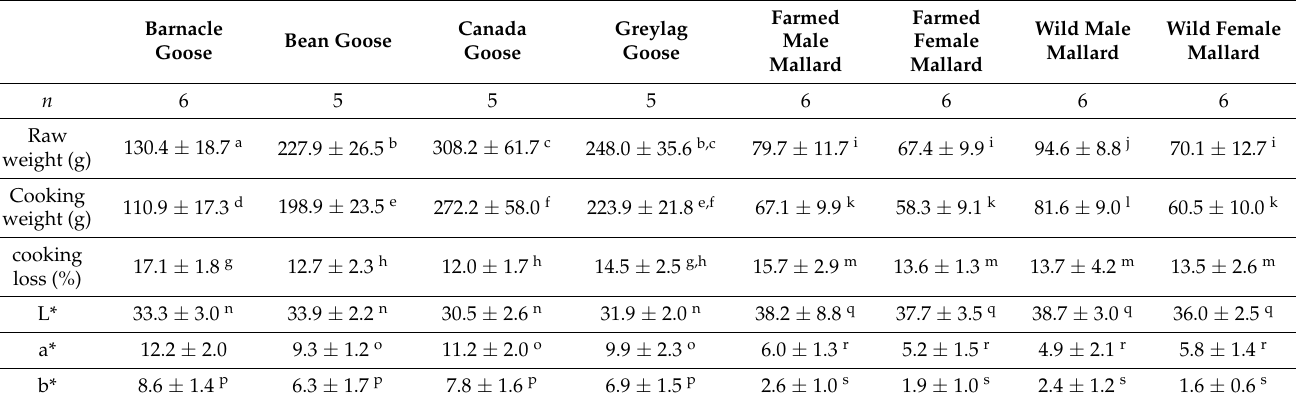
Table 5. Physical characteristics of meat from goose and mallard. Mean values ( ± sd) for raw weight (g), cooked weight (g), and cooking loss (%), together with the number of individual breast muscle samples ( n ) in all groups. Mean values ( ± sd) for lightness (L*), redness (a*), and yellowness (b*) are also given for each group. Significant differences between groups for each characteristic are indicated with uppercase letters a to s